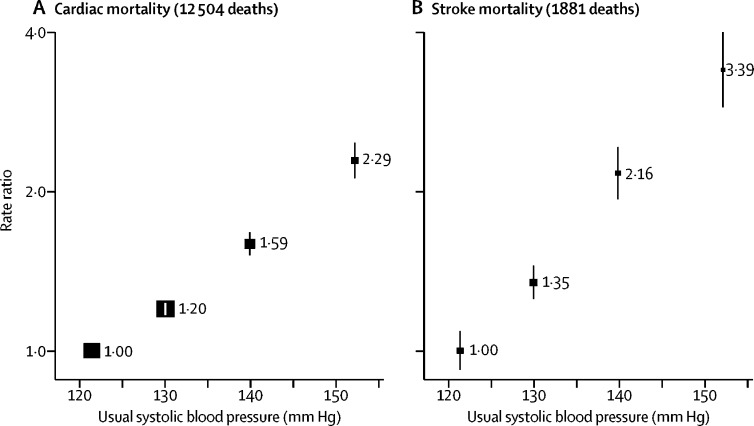
Usual systolic blood pressure vs cardiac (A) and stroke (B) mortality at ages 35–69 years in Chennai, IndiaRate ratios were adjusted for major confounders (age, sex, education, socioeconomic status, smoking, and alcohol) and body-mass index, and omitted the first 2 years of follow-up. Exclusions are as per table 1. For each systolic blood pressure category, the area of the square is inversely proportional to the variance of the category-specific log risk, which also determines the 95% CI (represented by error bars).